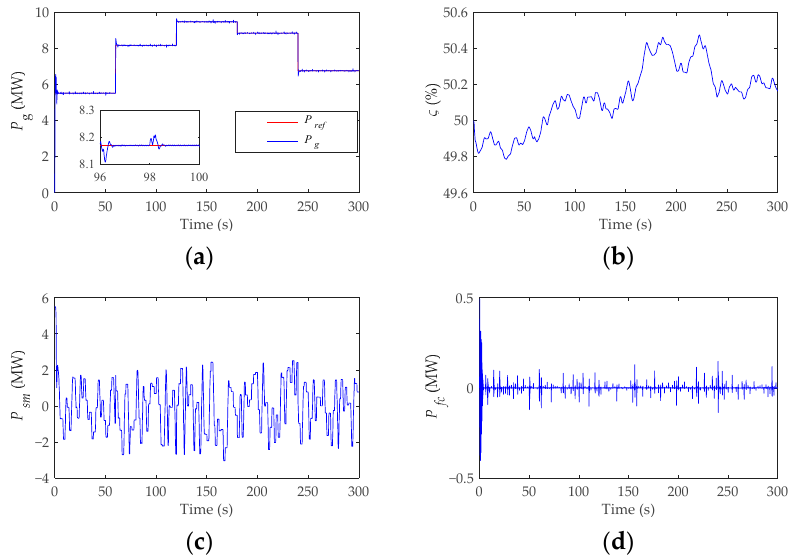
Figure 13. Power variation process of the BESS. ( a ) Tracking process of P g . ( b ) SoC of the BESS, ς . ( c ) Required BESS output for wind power smoothing, P sm . ( d ) Required BESS output for frequency control, P fc .